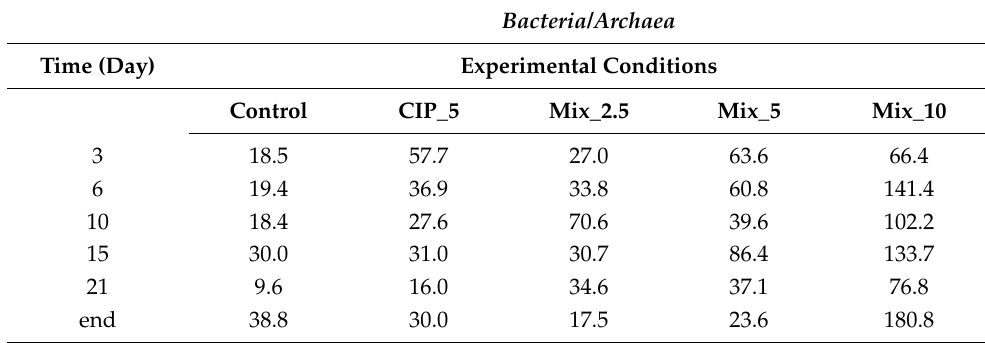
Table 1. Ratio of bacterial/archaeal cells under different experimental conditions and at different experimental times, calculated from the microbial abundance values of the respective components. Bacteria/Archaea Time (Day) Experimental